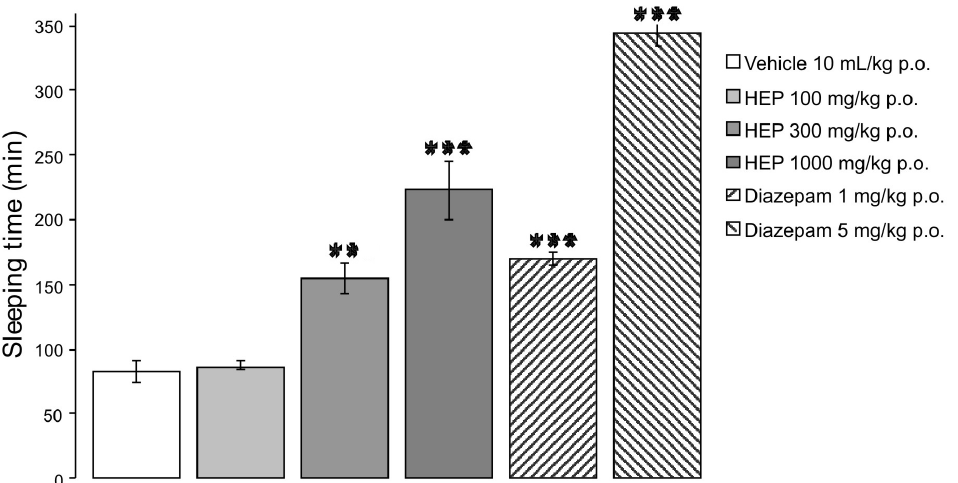
FIGURE 2 - Effect of hydroalcoholic extract from Lafoensia pacari on sleeping time (min) in pentobarbital-induced sleep time test in mice (n = 9) pre-treated (60 min, p.o.) with vehicle (saline, 10 mL/kg), hydroalcoholic extract from Lafoensia pacari stem bark (HEP, 100, 300 or 1000 mg/kg) or diazepam (DZP, 1 or 5 mg/kg). The columns and vertical bars express means ± SEM. ** p ≤ 0.01, *** p ≤ 0.001 compared with control group. TABLE III – Effects of hydroalcoholic extract from Lafoensia pacari (HEP) on elevated plus maze test, 60 minutes after treatments Experimental group